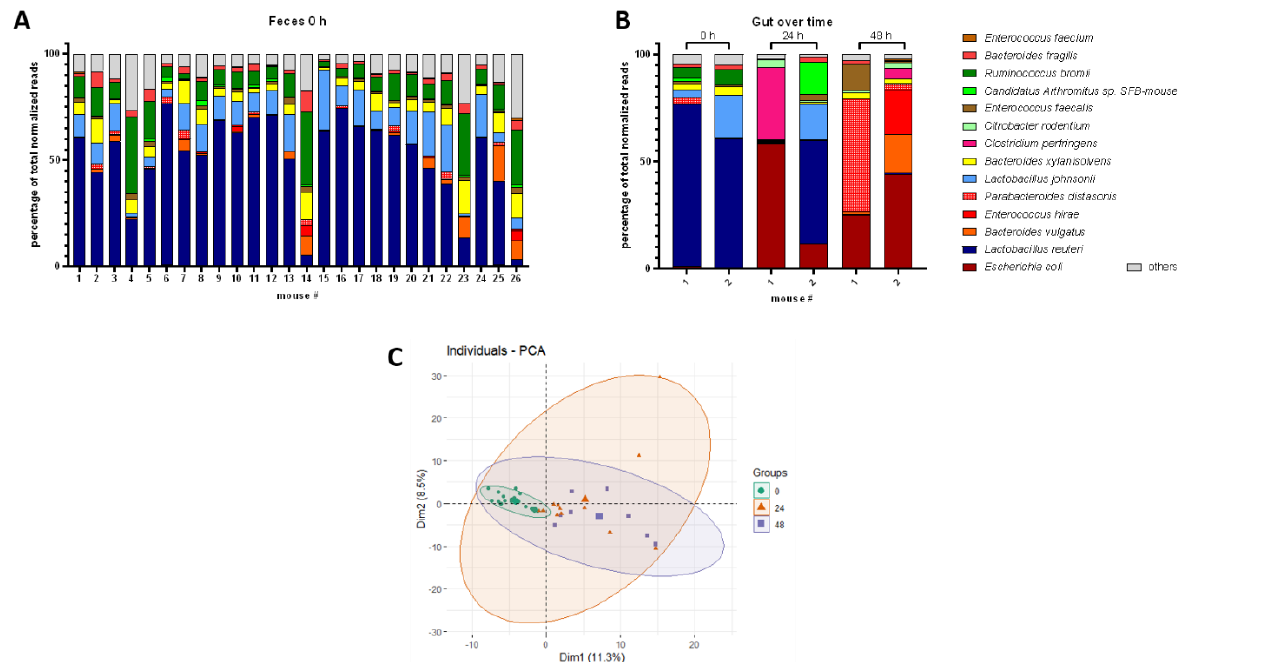
Figure 2. Healthy and post-CLP gut microbiome. ( A ): Healthy gut microbiome (0 h), percentage share of total normalized sequencing reads of top species shown for different mice. ( B ): Septic gut microbiome at 0 h, 24 h, and 48 h post-CLP, percentage share of total normalized sequencing reads of top species shown for different mice. ( C ): PCA of microbiomes at 0 h, 24 h, and 48 h post-CLP. Time points are indicated by color and shape of the symbols; bold symbols are centroids of the corresponding group.